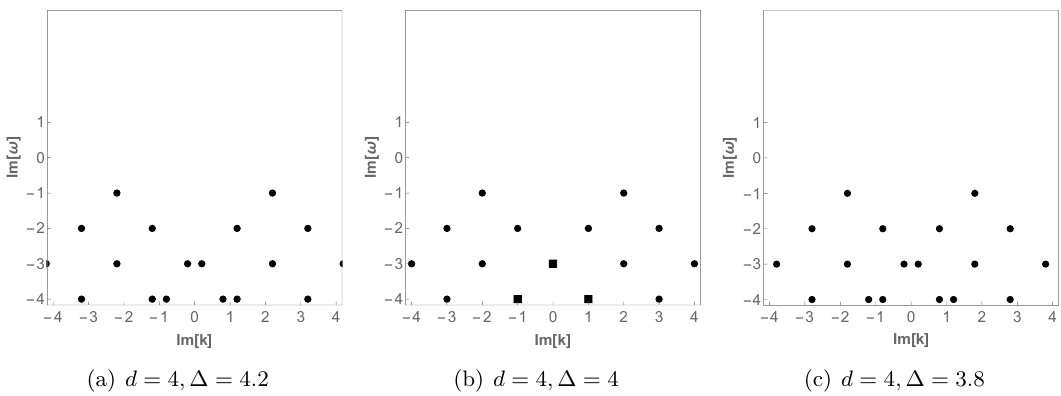
Figure 6 . The pole-skipping points of scalar field obtained from near horizon analysis. Black circles denote type-I while Black squares denote type-II points.